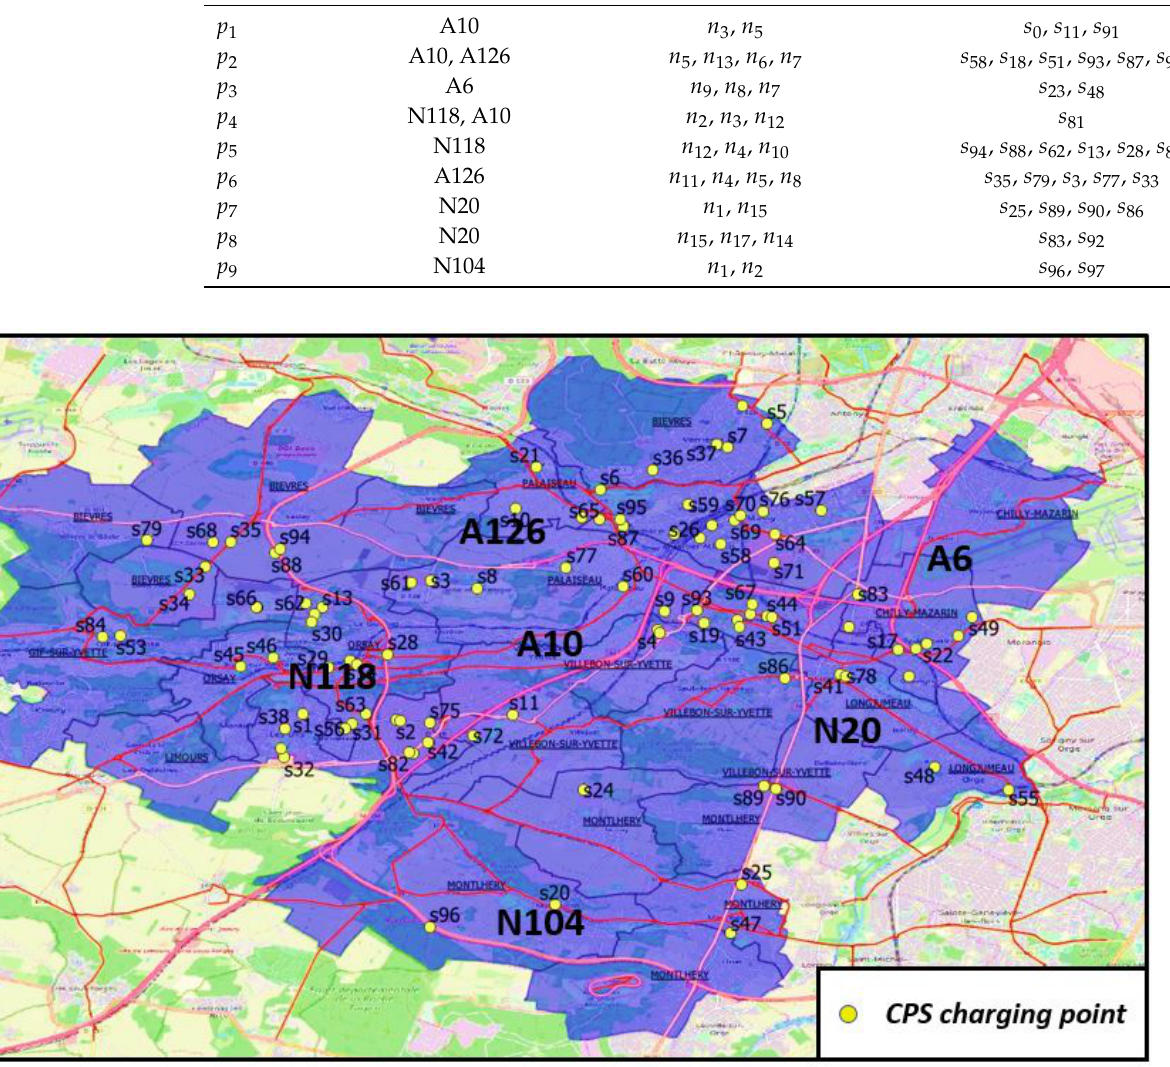
Figure 3. EV charging network-CPS charging